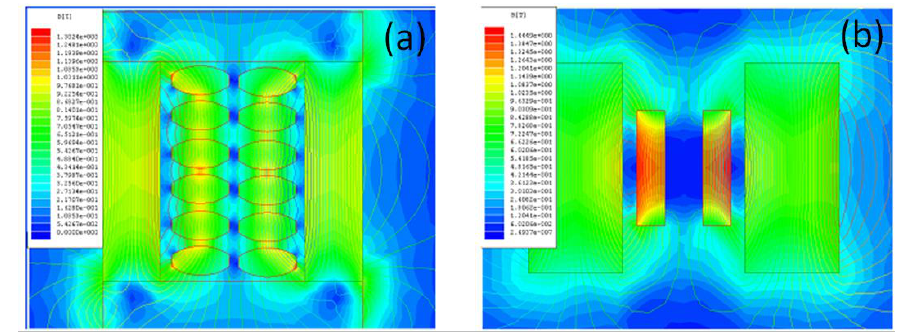
Figure 16. Magnetic field patterns (a) when the ferrite particles are placed between the magnets; and (b) when ferrite plates are placed.